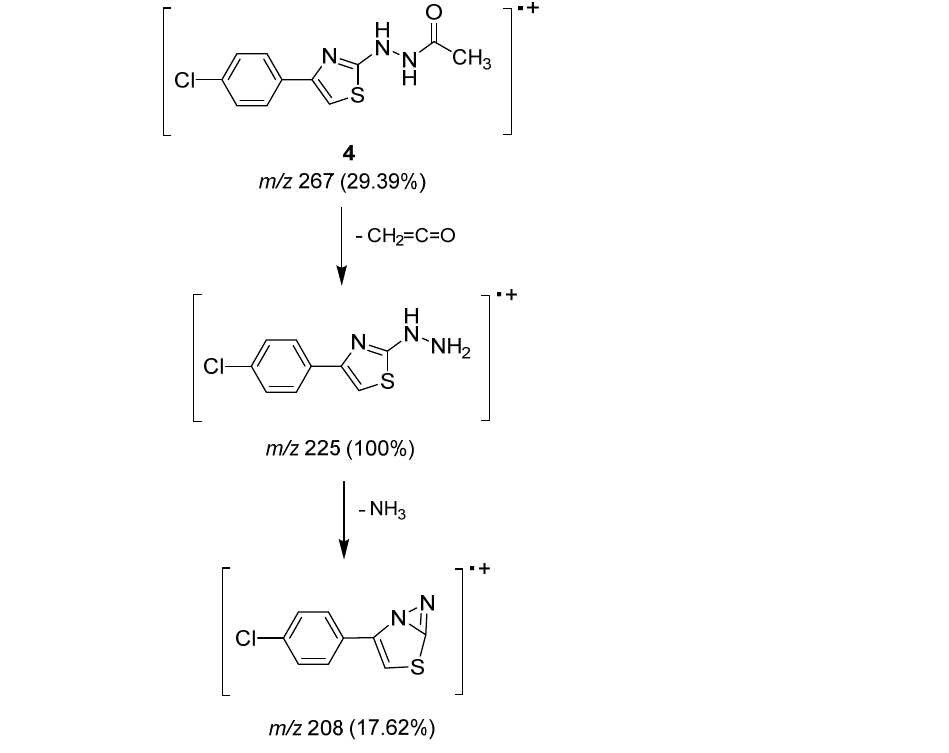
Scheme 6. The represented mass fragmentation pattern of compound